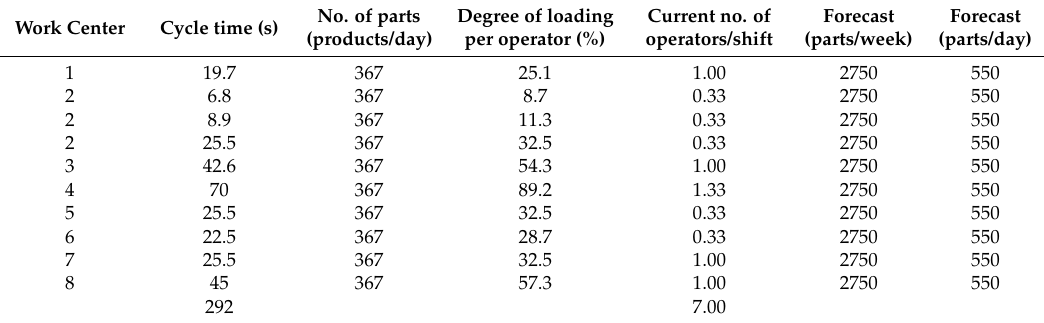
Table 4. Degree of loading per